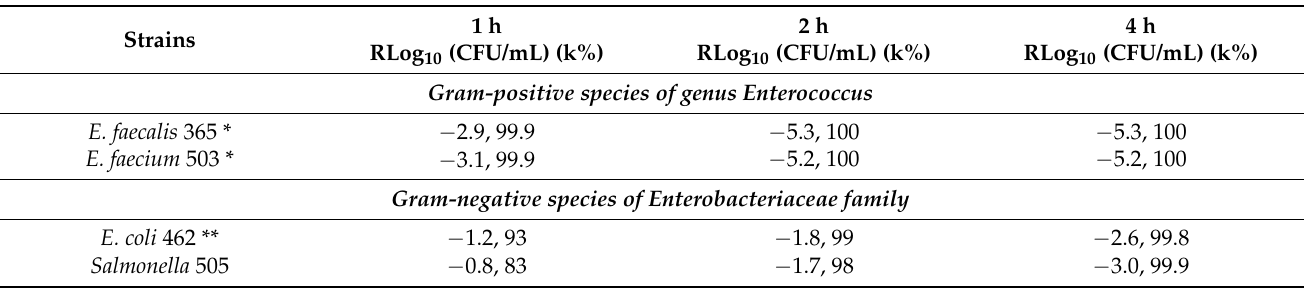
Table 5. Log 10 reduction in the initial cell number of the tested bacteria expressed in CFU/mL and killing percentages of bacteria tested singularly when exposed to R4 for 1, 2, and 4 h.